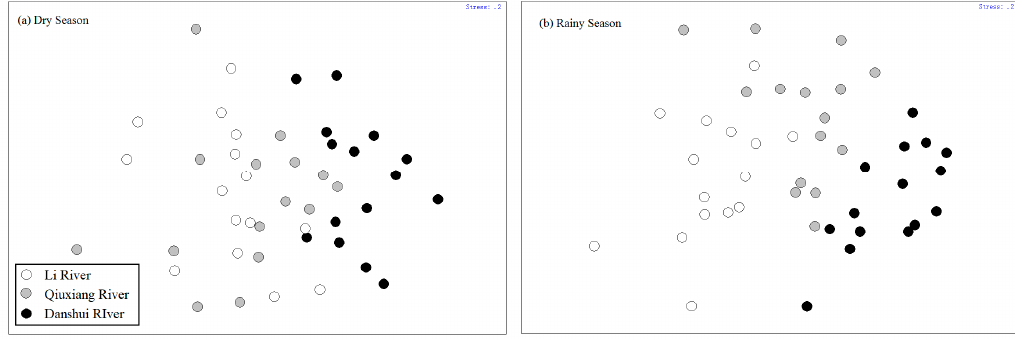
Figure 3. Multidimensional scaling (MDS) plots using Bray–Curtis distance and showing phytoplankton communities in the ( a ) dry and ( b ) rainy season. Points represent samples collected from the different tributaries and those closer together represent assemblages that are more similar. Table 4. Results of the similarities analysis global and pair-wise comparisons among the three tributaries. Among